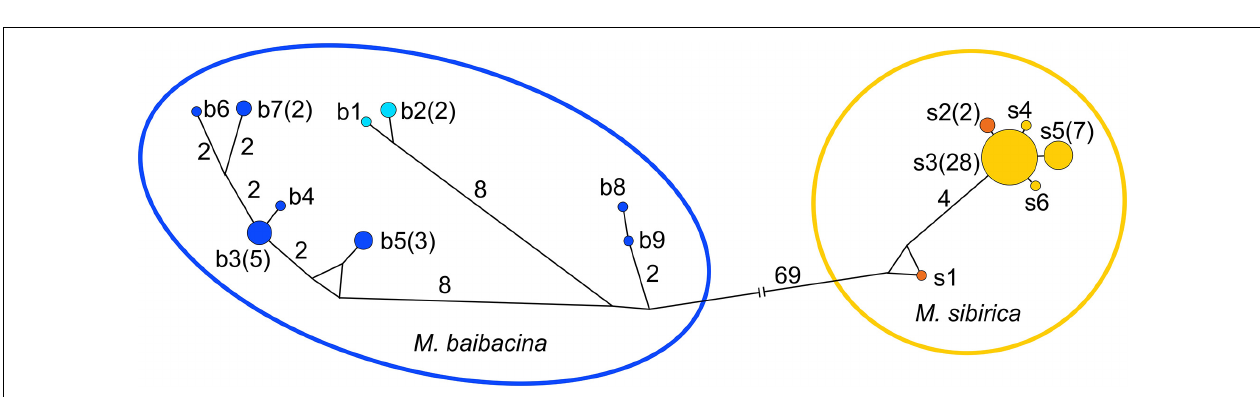
FIGURE 4 | Spatial distribution of genotyped individuals in the area of cohabitation of two species of marmots (it is marked by a red dotted frame in Figure 3 ). Symbols: orange circle— M. sibirica ; blue square— M. baibacina ; green rhombus—hybrid; white circle—single-family individuals; red oval indicates the area of boulder screes. Family identification numbers are in square brackets (see Table 1 ).